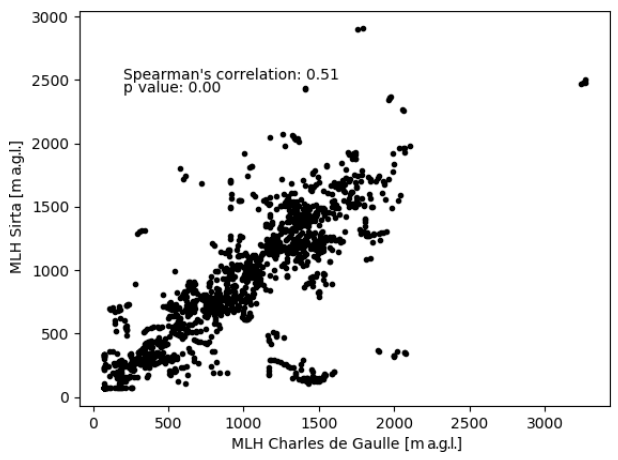
Figure A1. Scatterplot for MLH [ma.g.l.] measured at SIRTA vs. MLH measured at Charles de Gaulle airport.